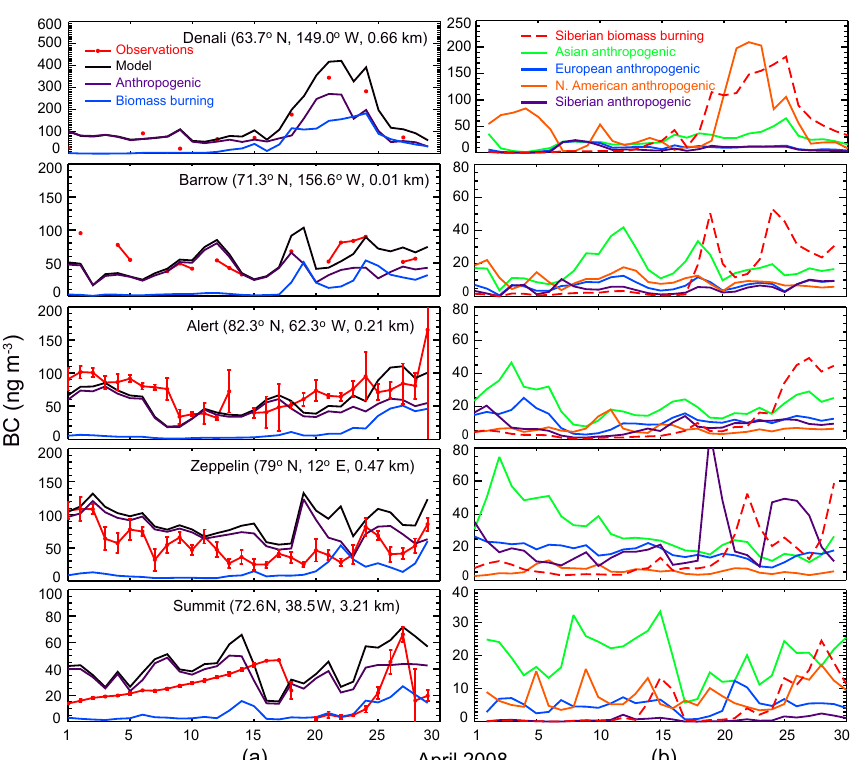
Figure 4. (a) Observed (red lines) and GEOS-Chem-simulated (black lines) daily mean BC concentrations at Denali, Barrow, Alert, Zeppelin, and Summit (see Fig. 1) for April 2008. Bars are standard deviations of observations. Modeled BC concentrations are decomposed into contributions from anthropogenic (purple lines) and biomass burning emissions (blue lines). Panel (b) indicates the major contributions: Siberian biomass burning (red dashed line), Asian anthropogenic (green solid line), European anthropogenic (blue solid line), North American anthropogenic (orange solid line), and Siberian anthropogenic (purple solid line)